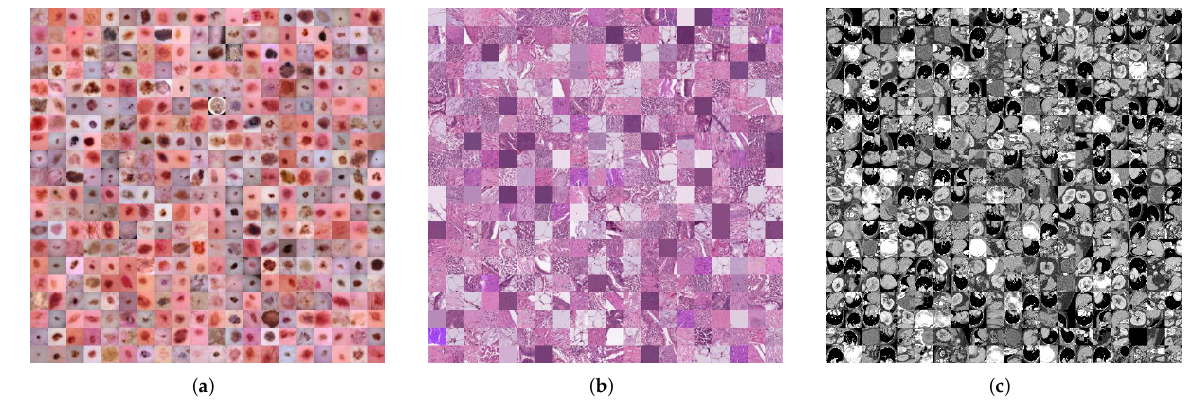
Figure 4. Medical image classification datasets. ( a ) DermaMNIST. ( b ) PathMNIST. ( c ) OrganM- NIST